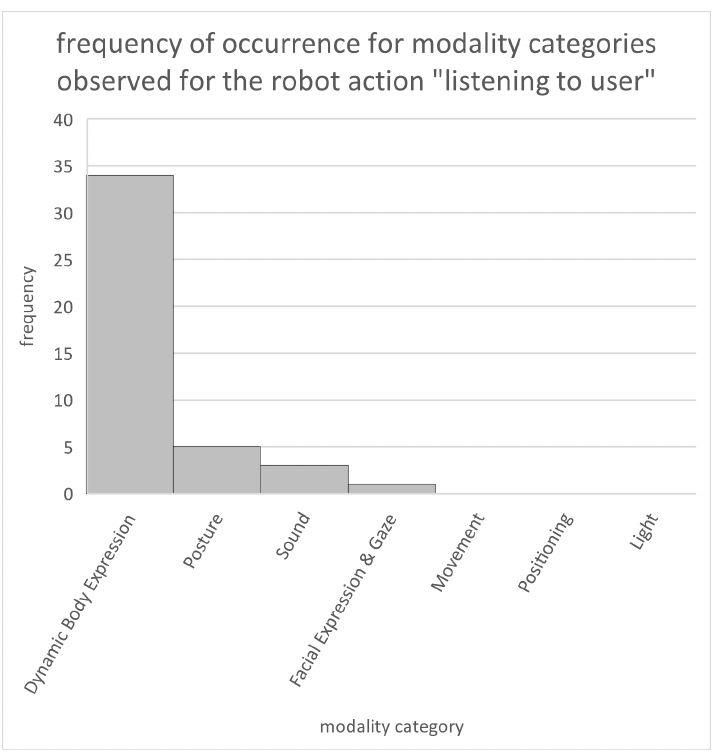
Figure 8. Overview of the frequencies of occurrence for the modality categories mentioned by the participants to describe the behavior displayed by the robot for the action “listen to user”. Participants rated the comprehensibility and the pleasantness of the behavior as high ( M = 2.76 SD = 0.48 and M = 2.31 SD = 0.67,